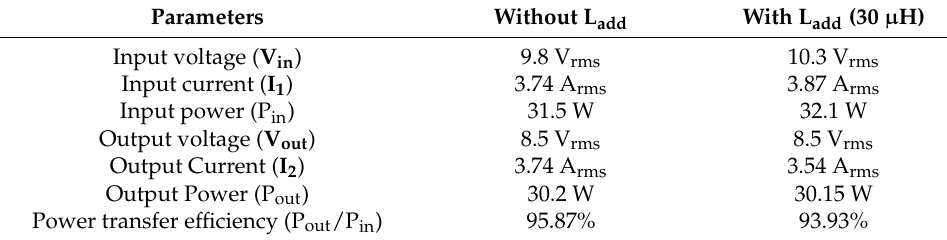
Table 8. Simulation results of a 30 W class WPT system according to the presence of L add (30 μH ).